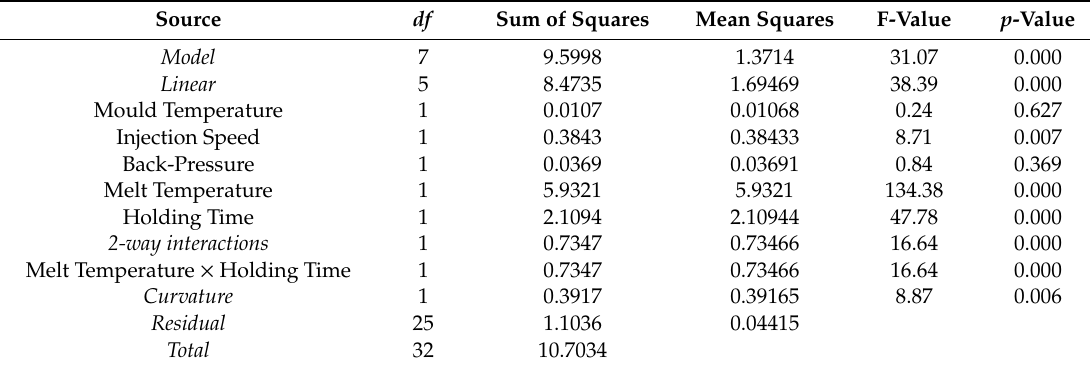
Table 3. Analysis of variance linear model for ultimate tensile strength against processing parameters.